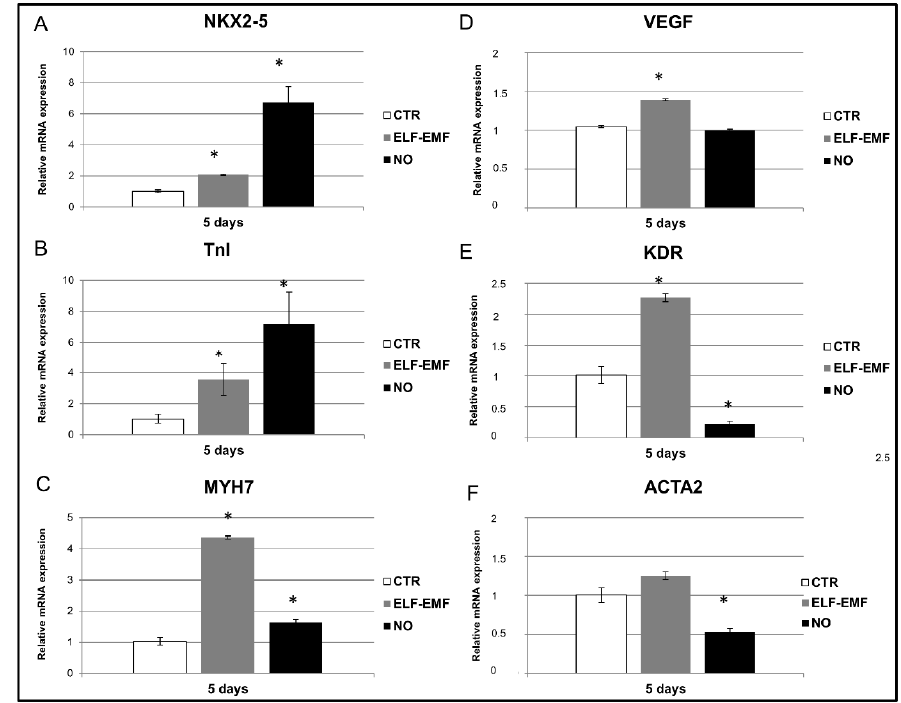
Figure 3. Cardio‐angiogenic commitment of hAMSCs by qPCR analysis: ( A – C ) study of the NKX2‐5, TnI and MYH7 cardiac markers’ expression in 5 days 7 Hz, 2.5 μT exposed cells (ELF‐EMF) and in 0.4 mM Nitric Oxide (NO) treated cells compared to control ones (CTR); ( D – F ) qPCR analysis of the angiogenic markers VEGF, KDR and ACTA2 in 5 days 7 Hz, 2.5 μT exposed cells (ELF‐EMF and in 0.4 mM Nitric Oxide (NO) treated cells compared to control ones (CTR). Statistical evaluation of the data was assessed by using a Student’s t -test with p < 0.05 as the minimum level of significance. Data are shown as mean ± Standard Deviation (SD). Asterisks identify statistical significance ( p < 0.05) ( n =